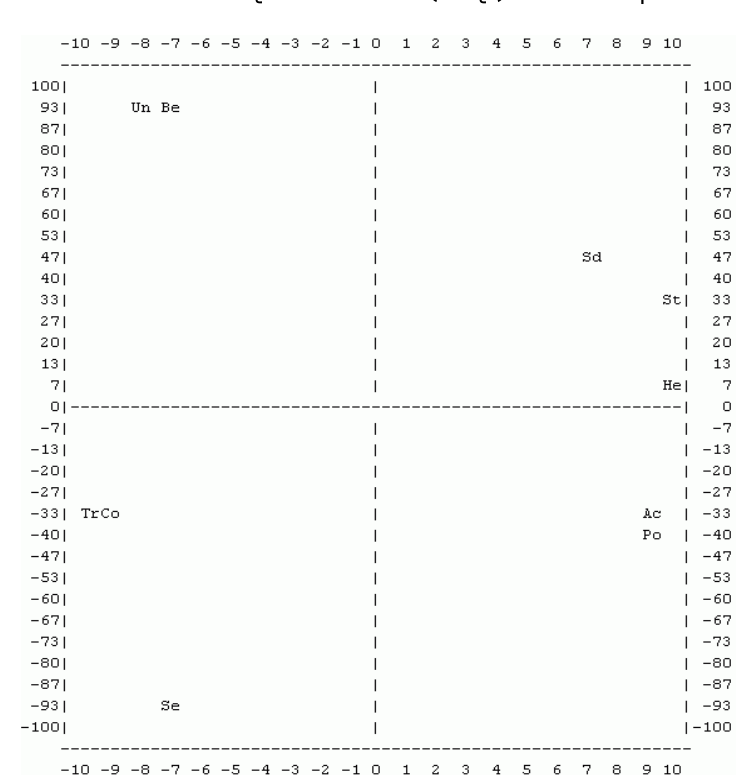
Figure 3. Portrait Values Questionnaire (PVQ) Smallest Space